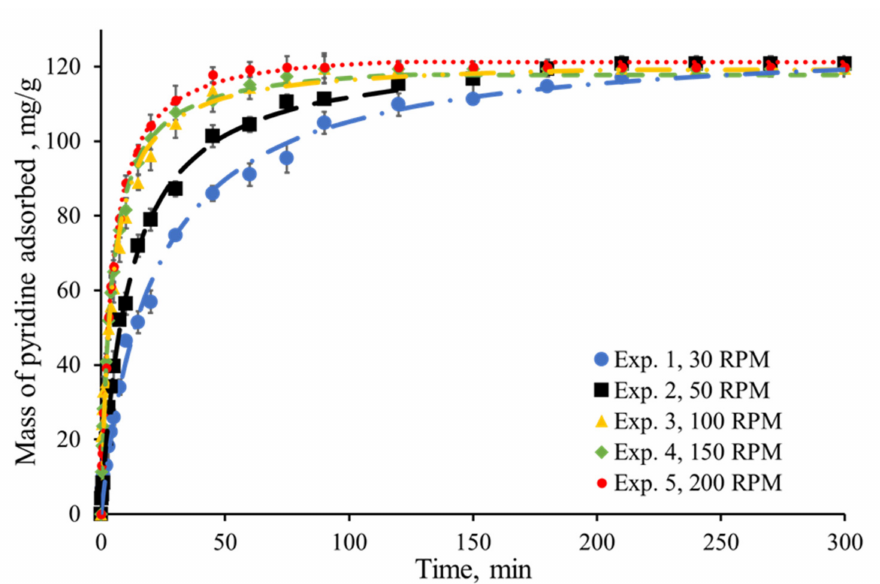
Figure 5. Variation in ACC adsorption capacity as function of stirring speed. Prediction by the Langmuir kinetic model is represented by dashed lines, while the discrete values correspond to the experimental